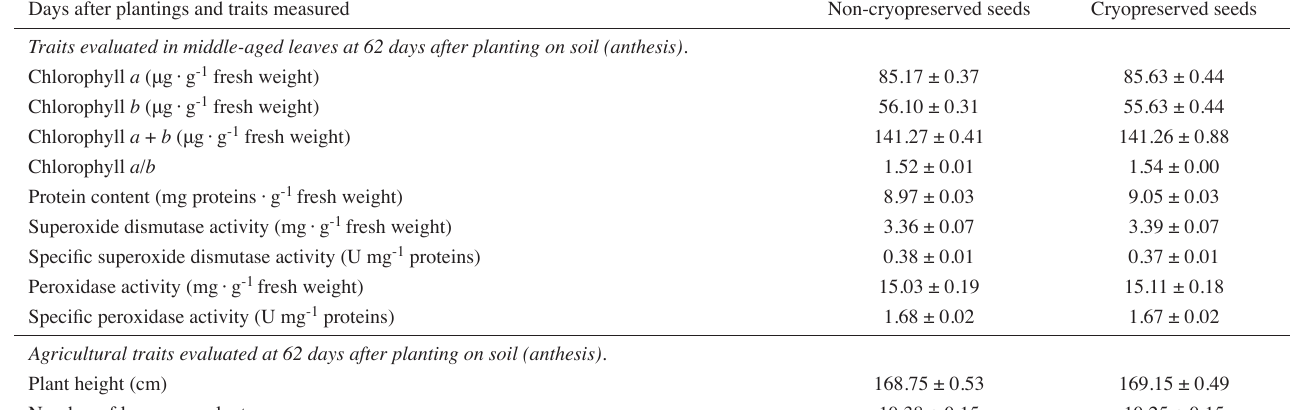
Tab. 2: Growth of adult plants in a plant bed until harvest at 110 days. Statistically significant differences were not recorded (t-test, p>0.05). Intervals represent average ± SE. Days after plantings and traits measured Traits evaluated in middle-aged leaves at 62 days after planting on soil